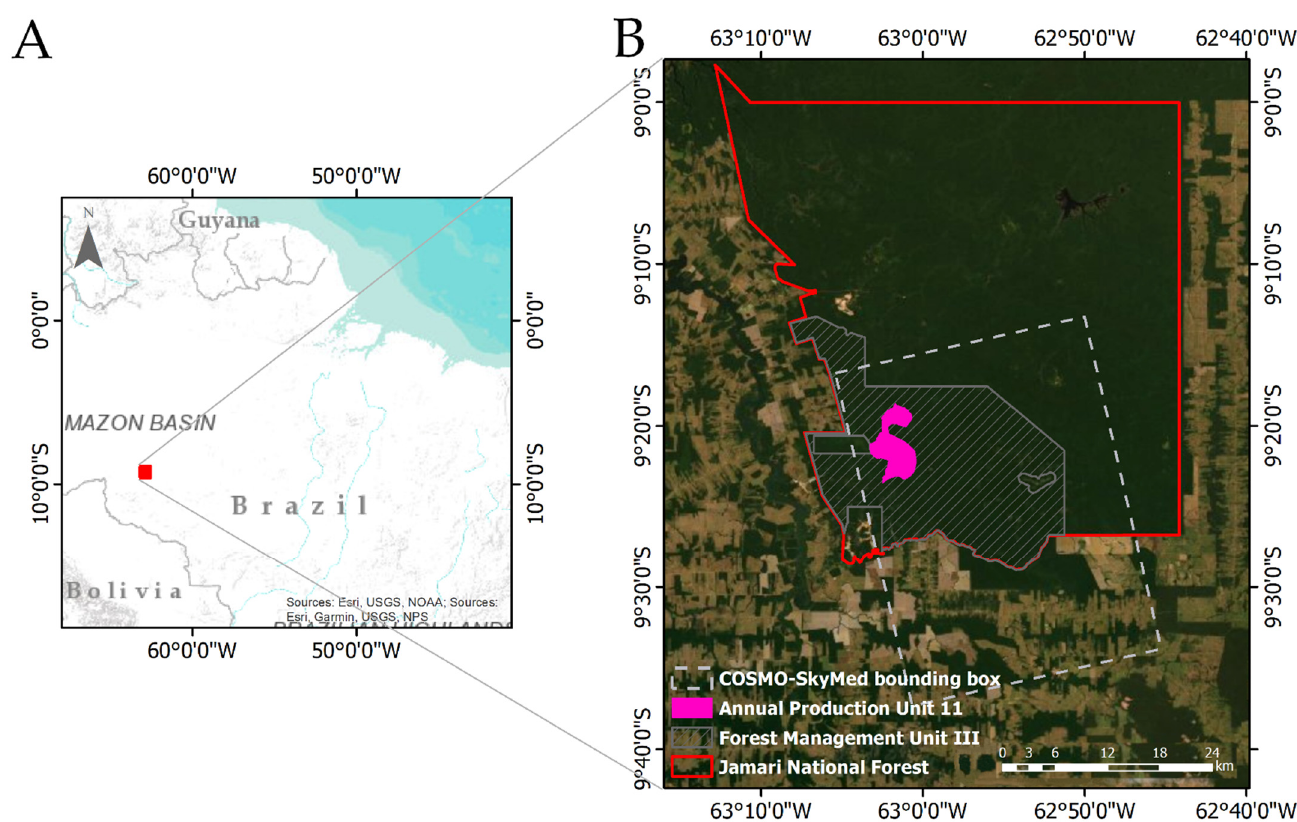
Figure 1. Location of the study area in the Rondônia State, Brazil ( A ); the study site in the Jamari NF ( B ).